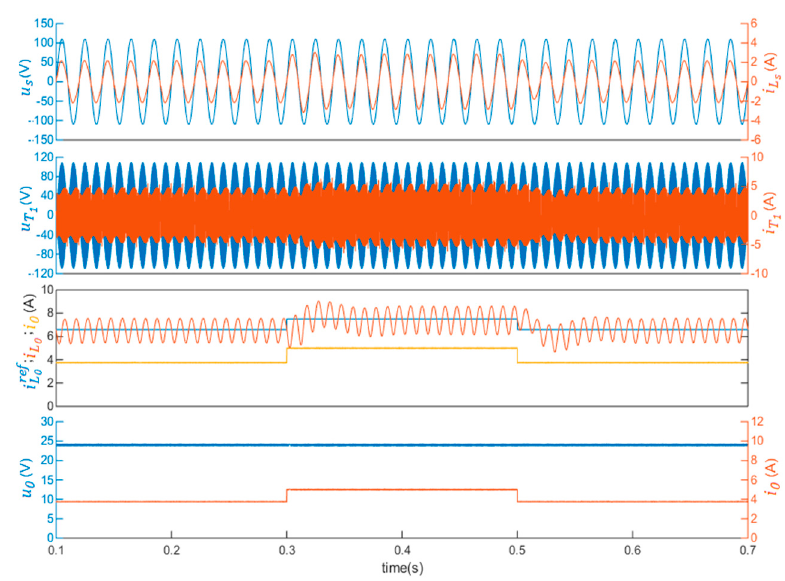
Figure 6. Time evolution in transient conditions.